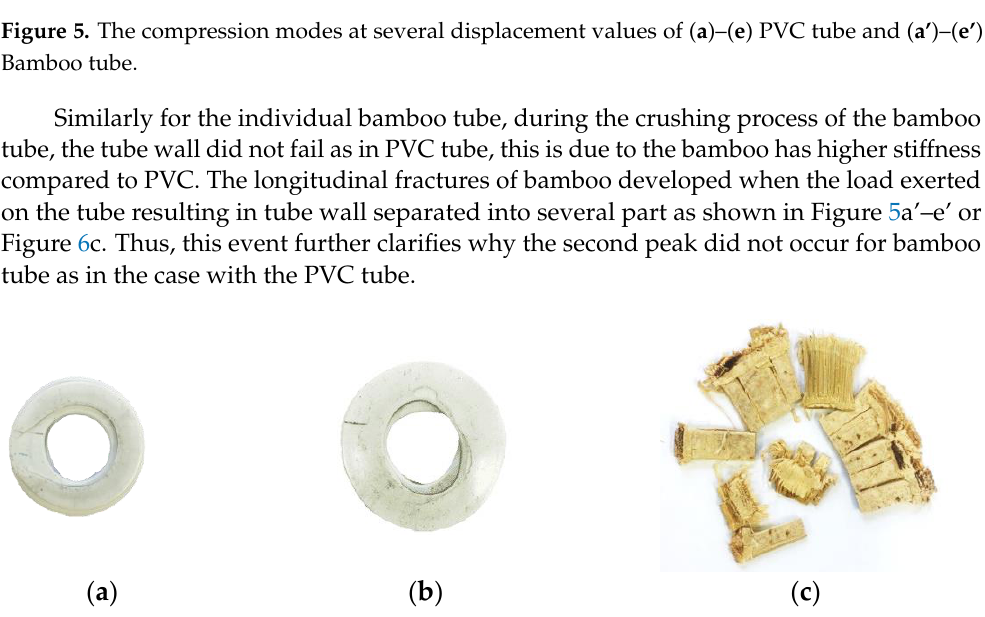
Figure 6. Shape of tube after deformation: ( a ) PVC Ø 20 ( b ) PVC Ø 25 and ( c ) Bamboo.